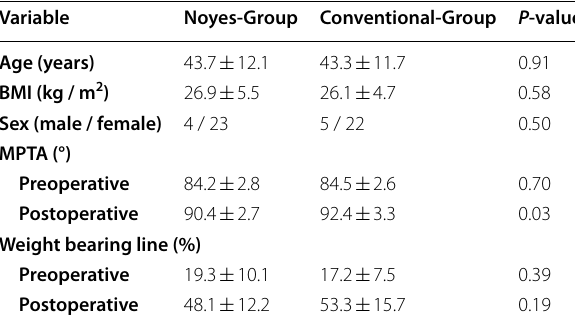
Demographics and surgical data of both groups. Values are presented as mean standard deviation ± MPTA Medial proximal tibial